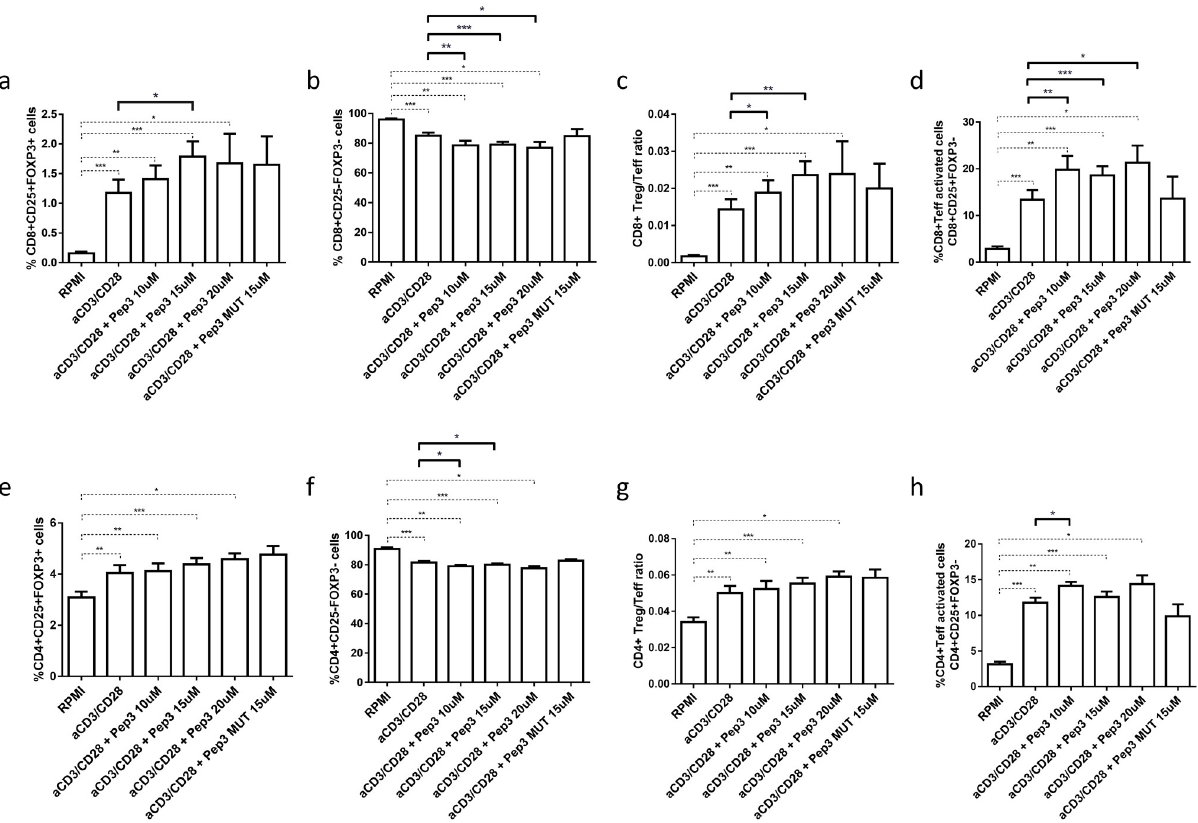
Fig 1. Frequency of T cell populations in PBMC isolated from healthy donors (HD) after treatment with peptide 3 and subsequent stimulation with anti-CD3/CD28 beads for 4 days. Flow-cytometry analysis of HD PBMC untreated unstimulated (RPMI) or stimulated (anti-CD3/CD28), treated with 10, 15 and 20 μ M Pep 3 or 15 μ M of Pep3 MUT and subsequently stimulated with anti-CD3/CD28 beads for four days. Percentages of CD8+ subsets (CD8+ Treg, CD8+ Teff, CD8+ Teff activated) were calculated on total CD8+ cells. Percentages of CD4+ subsets (CD4+ Treg, CD4+ Teff, CD4+ Teff activated) were calculated on total CD4+ cells. Percentages of total CD8+ and CD4+ cells were calculated on total lymphocytes. Graphs show the percentage of CD8+ Treg as CD8+ CD25+FOXP3+ cells ( a ), CD8+ Teff as CD8+ CD25-FOXP3- cells ( b ), CD8+ Treg/Teff ratio ( c ), CD8+ Teff activated cells as CD8+ CD25+FOXP3- cells ( d ), CD4+ Treg as CD4+ CD25+FOXP3+ cells ( e ), CD4+ Teff as CD4+ CD25-FOXP3- cells ( f ) (please refer for gating strategy to S1 Fig), CD4+ Treg/Teff ratio ( g ), CD4+ Teff activated cells as CD4+ CD25+FOXP3- cells ( h ). Values correspond to mean frequency ± SEM of 14 HD. � p < 0.05, �� p < 0.01, ��� p <